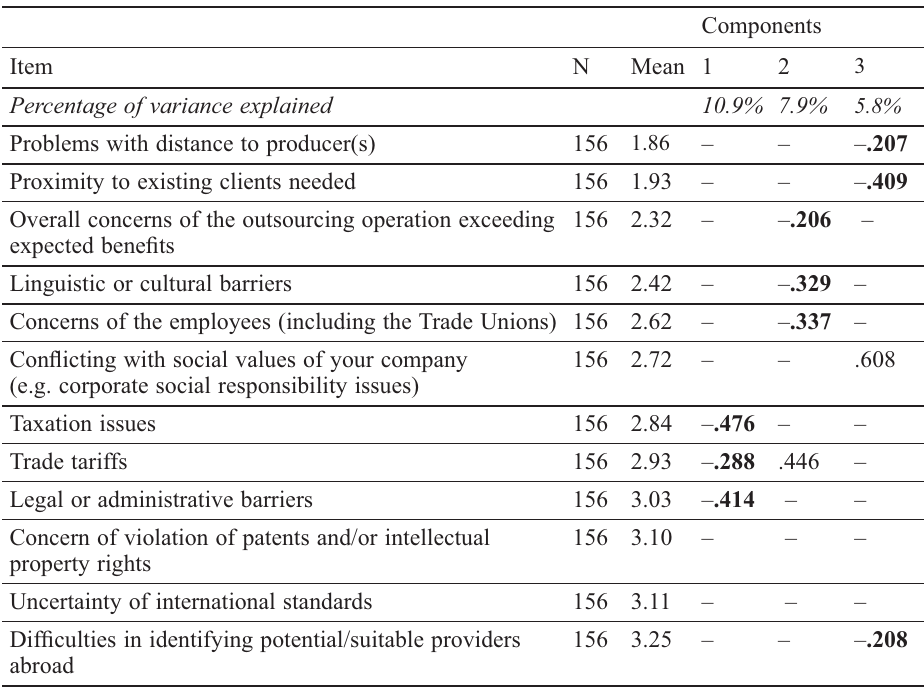
Table 5. Factor analysis for impediments to international outsourcing: core + support